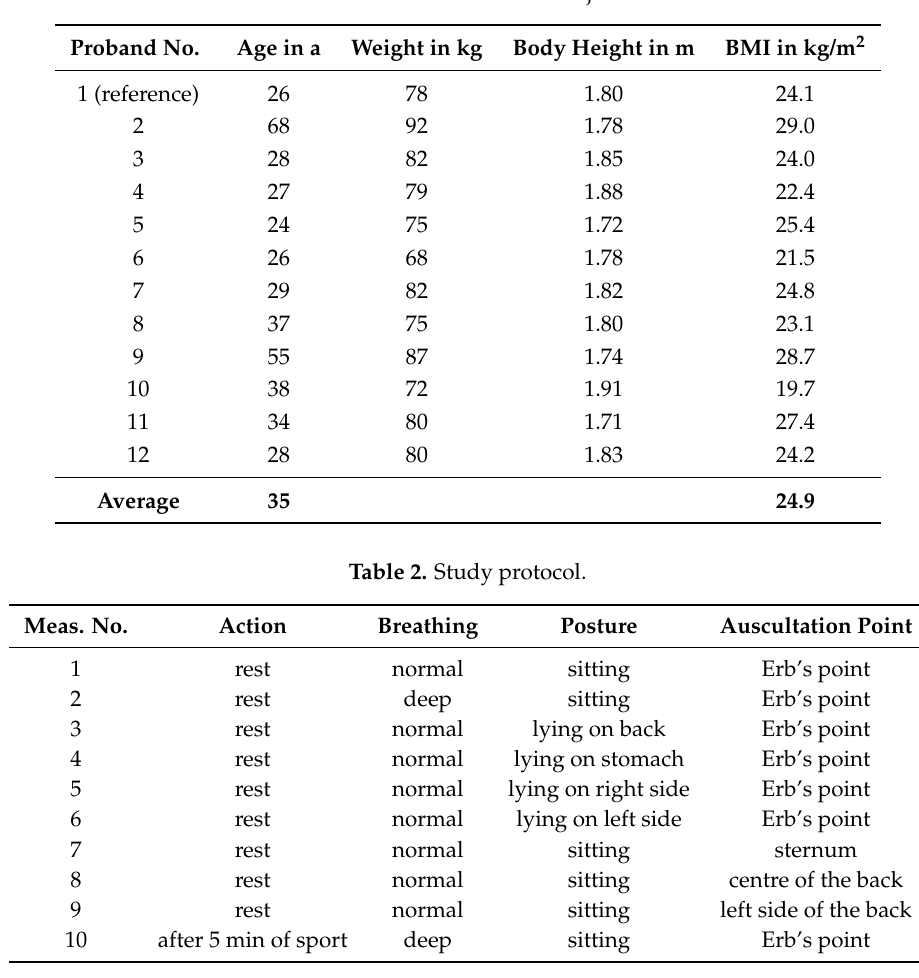
Table 1. Overview of the